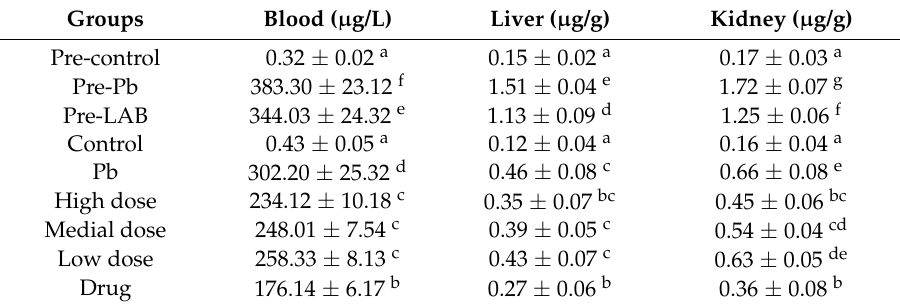
Table 5. Effects of L. bulgaricus KLDS1.0207 on Pb levels in the blood and tissue of